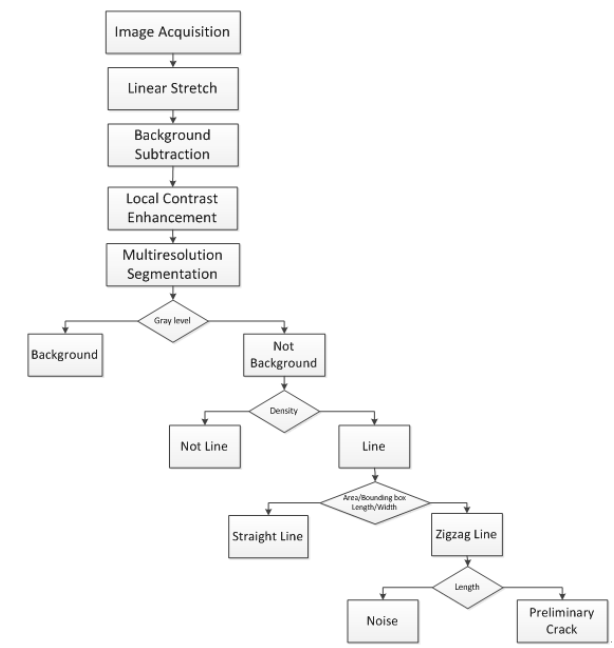
Figure 5. The workflow of automatic crack